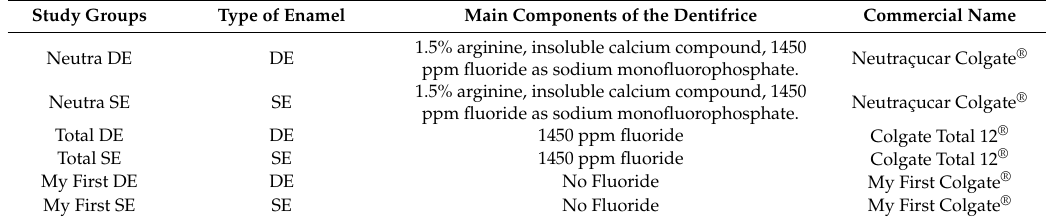
Table 1. Study groups by type of enamel specimen and dentifrice